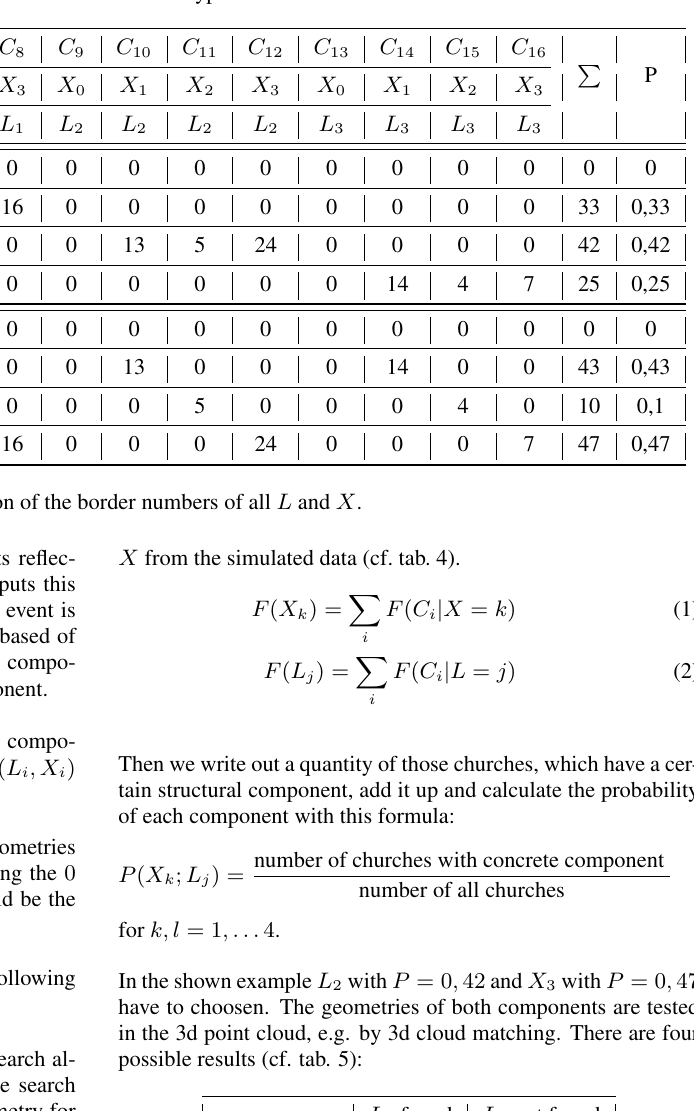
Table 3: Simulation of numbers all 16 types of churches.